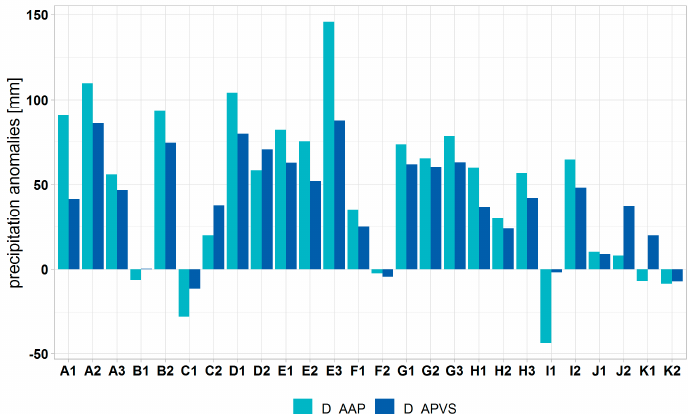
Figure 4. The variation of average annual precipitation on the decades for the provenance subregions.